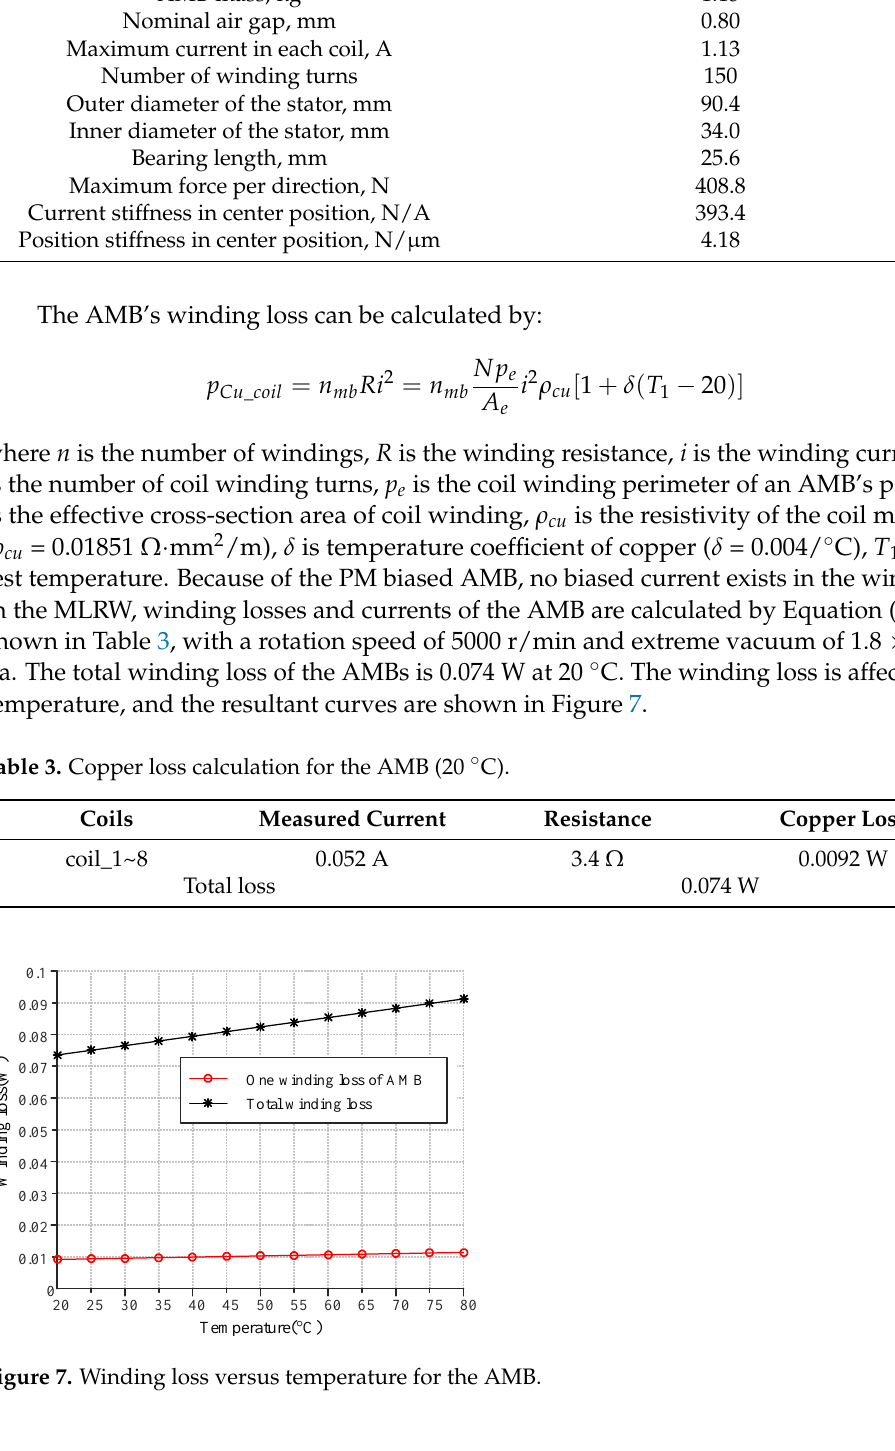
Table 2. Design parameters of the AMB.